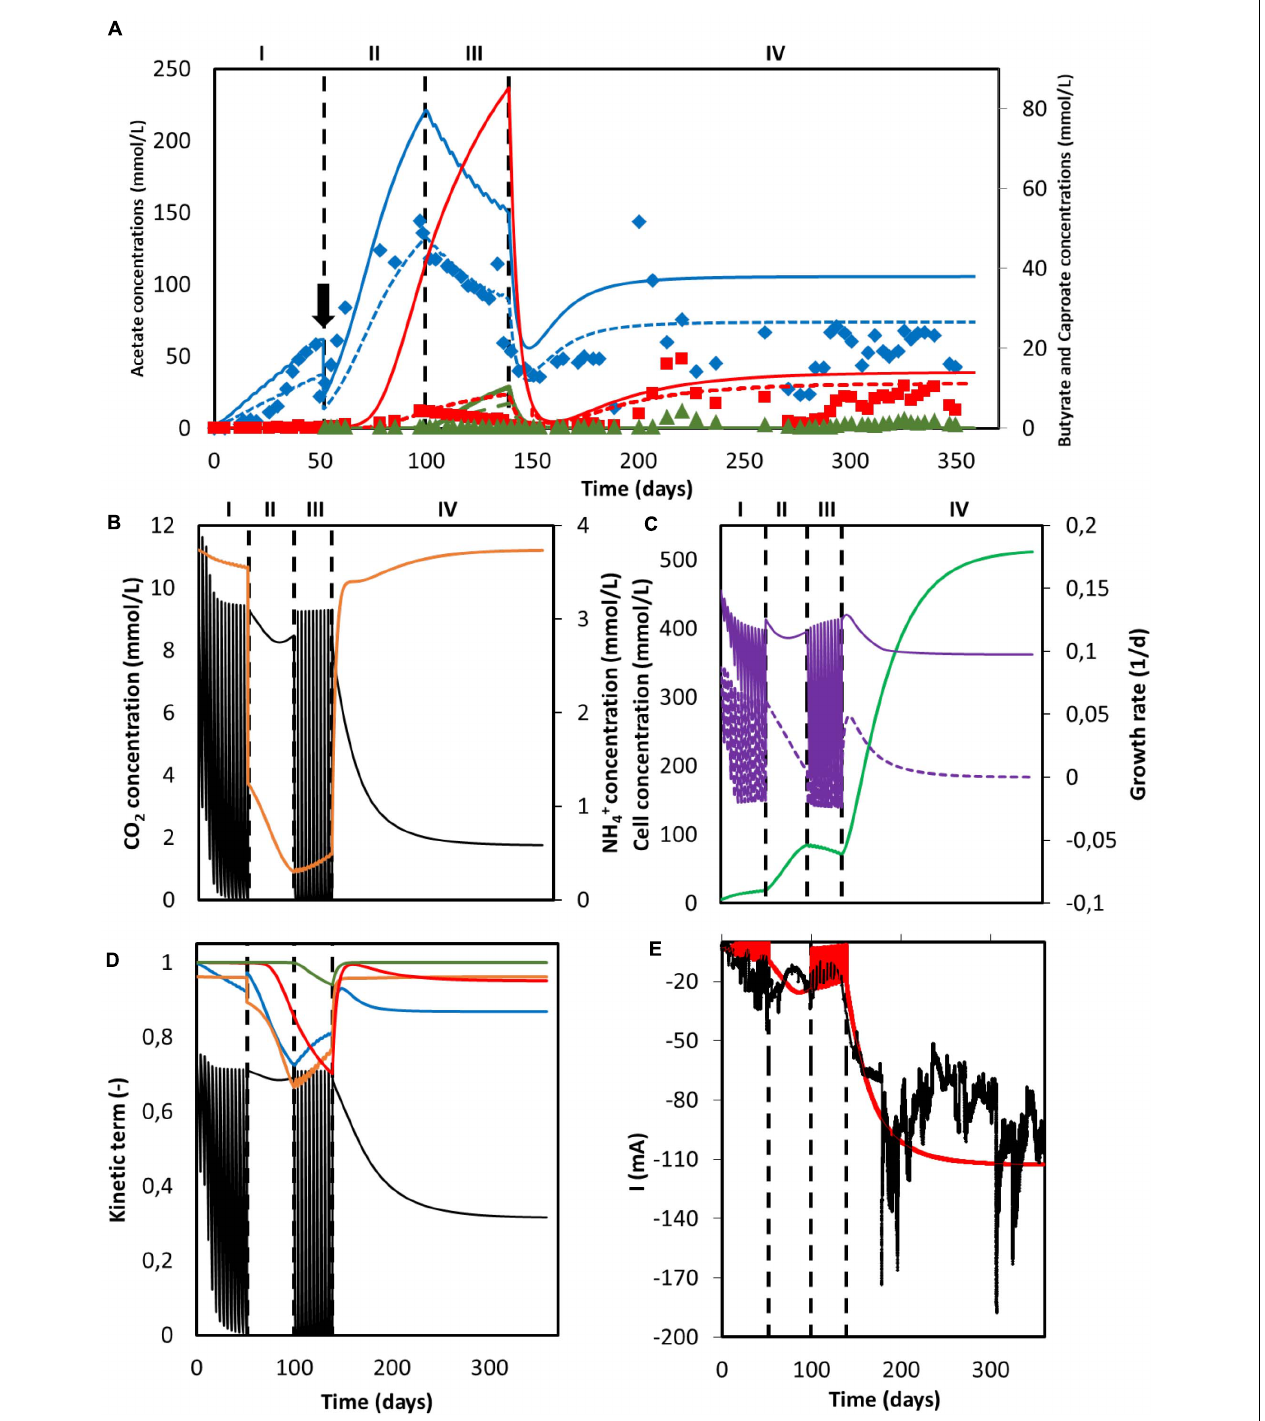
FIGURE 4 | Simulation results of a MES system with changing feed strategies and operational modes. (A) Predicted concentration of acetate (solid blue line), n-butyrate (solid red line) and n-caproate (solid dark green line) and experimental data from Jourdin et al. (2018) of acetate (blue diamonds), n-butyrate (red squares), and n-caproate (dark green triangles). Adjusted concentrations with reported electron recoveries are shown with dashed lines for acetate (blue), n-butyrate (red), and n-caproate (dark green); (B) Concentration of CO 2 (black) and NH 4 + (orange); (C) Microbial cell concentration (light green), calculated maximum growth rate (purple), and growth rate (purple dashed line); (D) Kinetic hyperbolic uptake terms of CO 2 (black) and NH 4 + (orange), and kinetic product inhibition terms of acetate (blue), n-butyrate (red), and n-caproate (dark green); (E) Predicted (red) and experimental (black) current. The vertical dashed lines represent the time when reactor operation was switched from fed-batch to batch and from batch to continuous mode. The black arrow indicates when substantial leakage of the medium occurred.